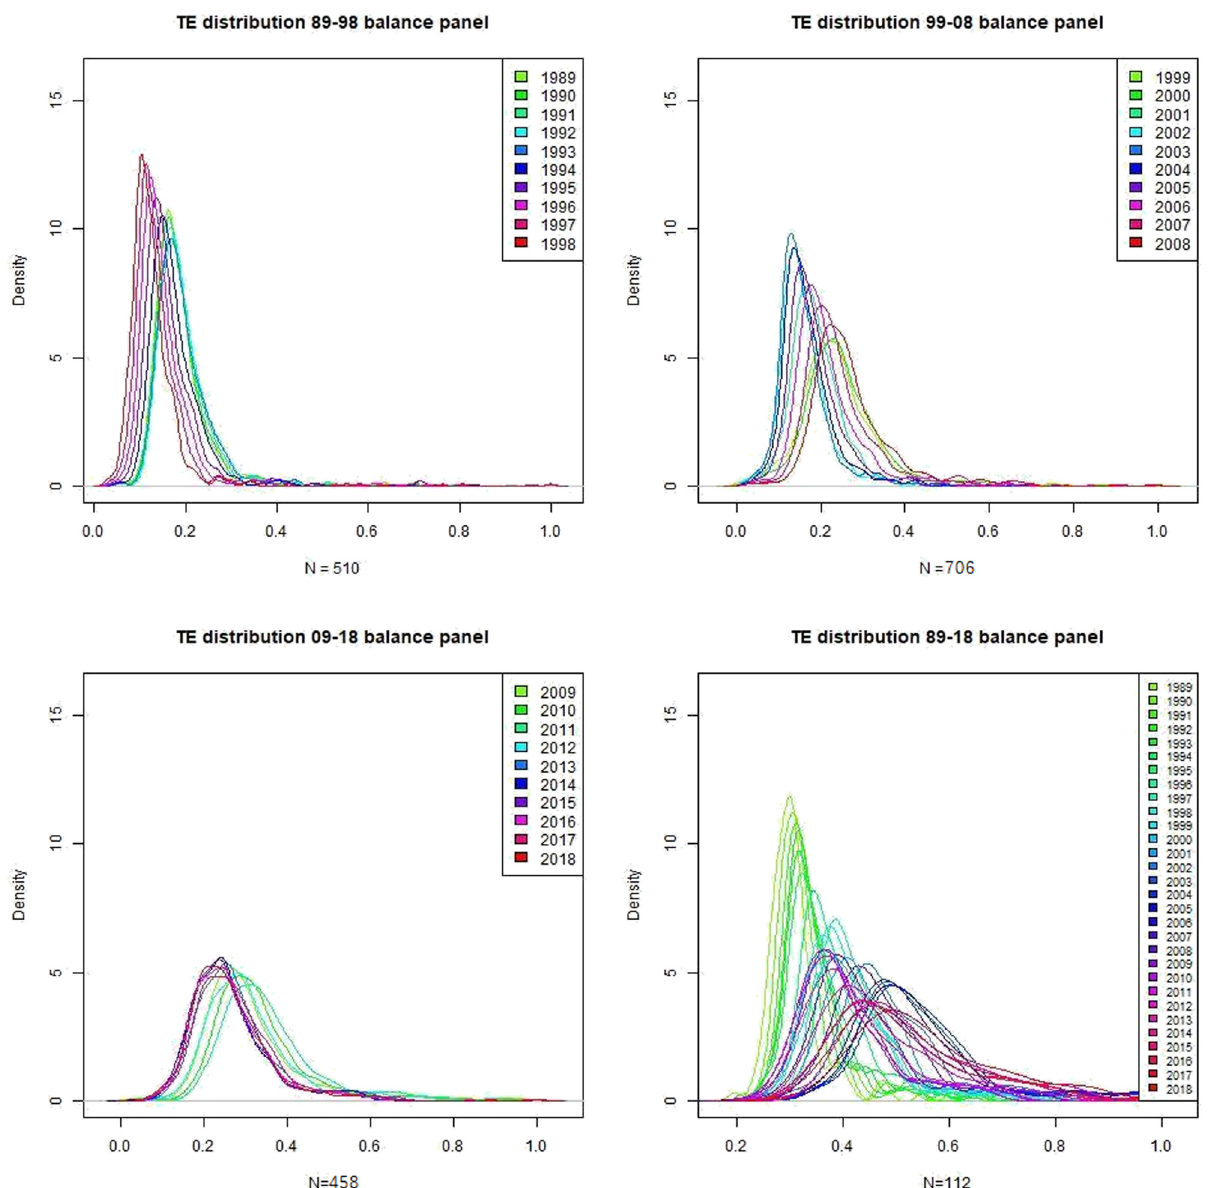
Figure 1: Distribution of TE in the balanced